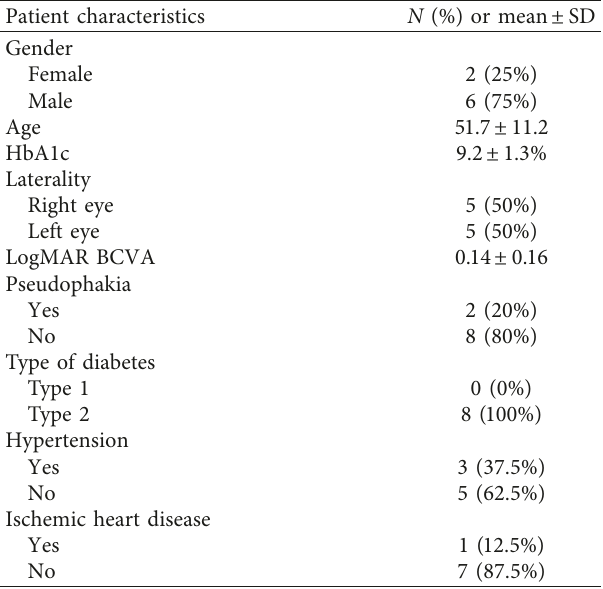
Table 1: Baseline characteristics of study participants ( N � 10 eyes in 8 patients).